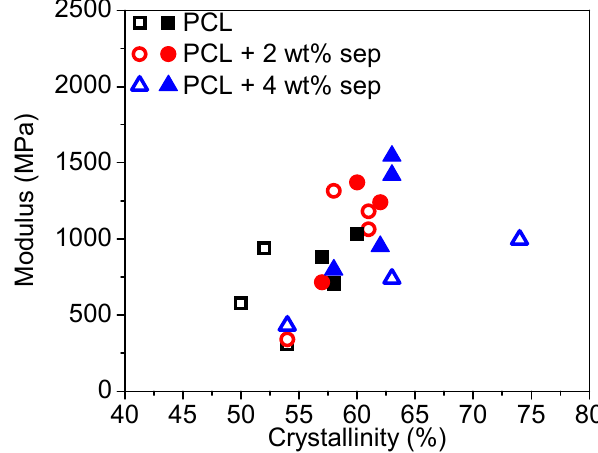
Figure 14. Plot depicting the elastic modulus versus degree of crystallinity. The open symbols are for samples cooled with open chill rolls, while the closed symbols are for samples cooled with closed chill rolls.